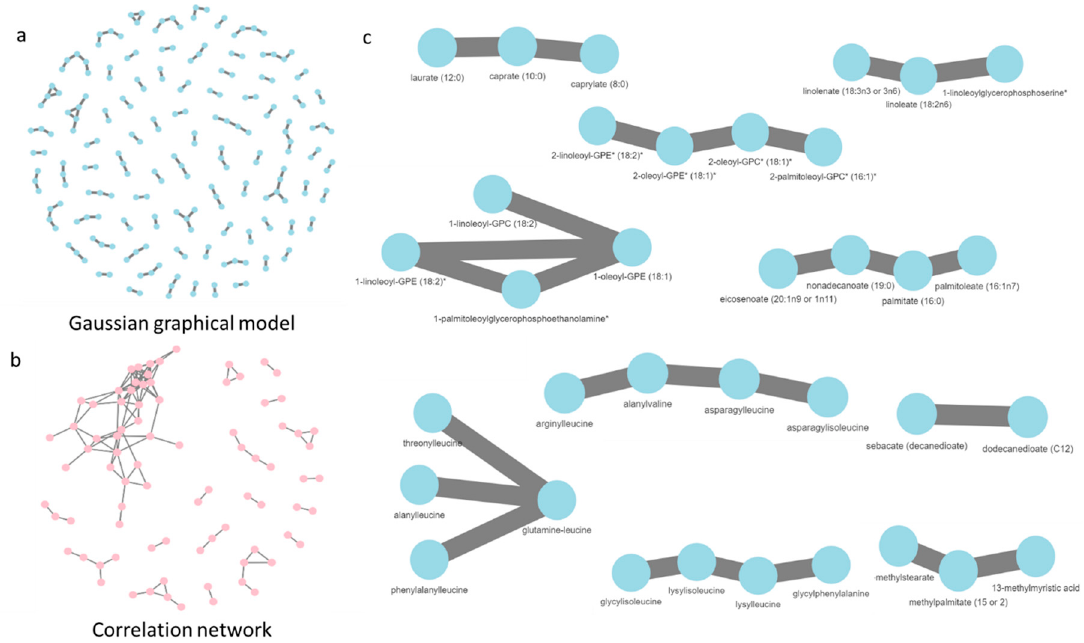
Figure 3. ( a ) GGM constructed using complete dataset (31 flies) showed 129 edges which included most of the edges found in the individual diet GGMs ( b ) The correlation network showed has 130 edges even with a cutoff of 0.9235, thus highlighting the inherent higher correlational structure in the metabolome ( c ) The fatty acid, phospholipid, and dipeptide subnetworks identified by GGM that are not present in correlation network (Interactive network visualization can be found in Supplemental Files: Figure_S3a_complete_ggm.html and Figure_S3b_correlation_netwrok.html).